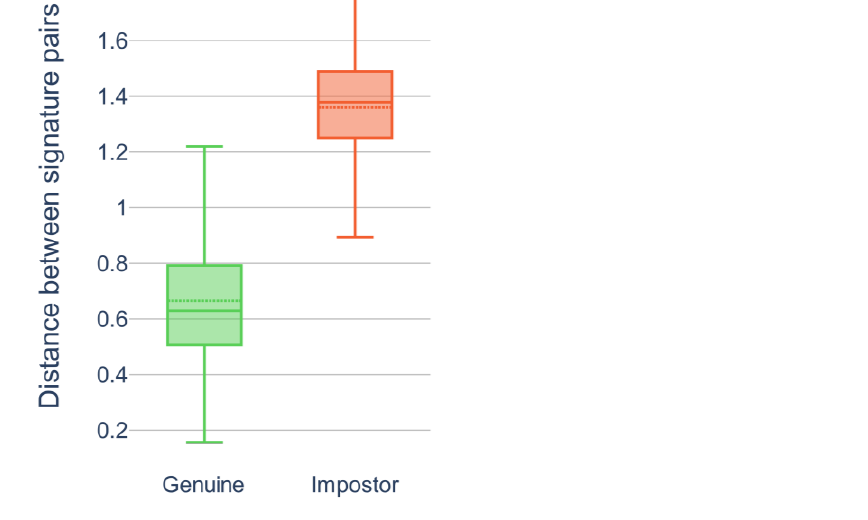
Figure 13. Boxplot of distances between signature pairs for “ Genuine ” and “ Impostor ” case.